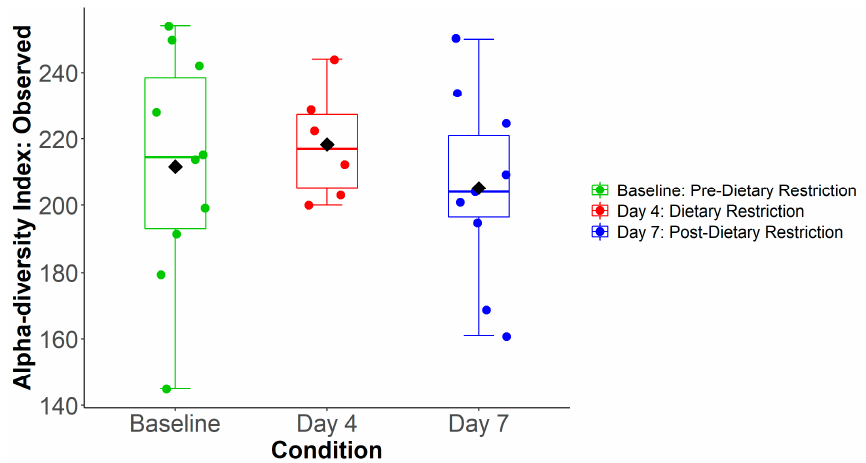
Figure 2. Alpha Diversity. Average number of observed species was not found to be different between conditions.